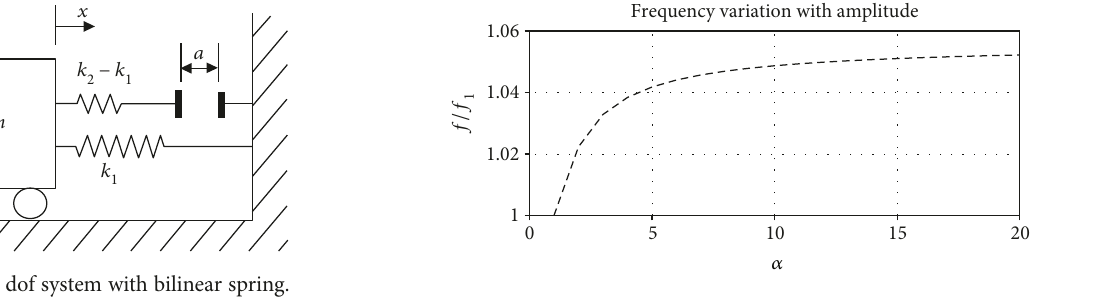
Figure 2: Normalized frequency with di ff erent